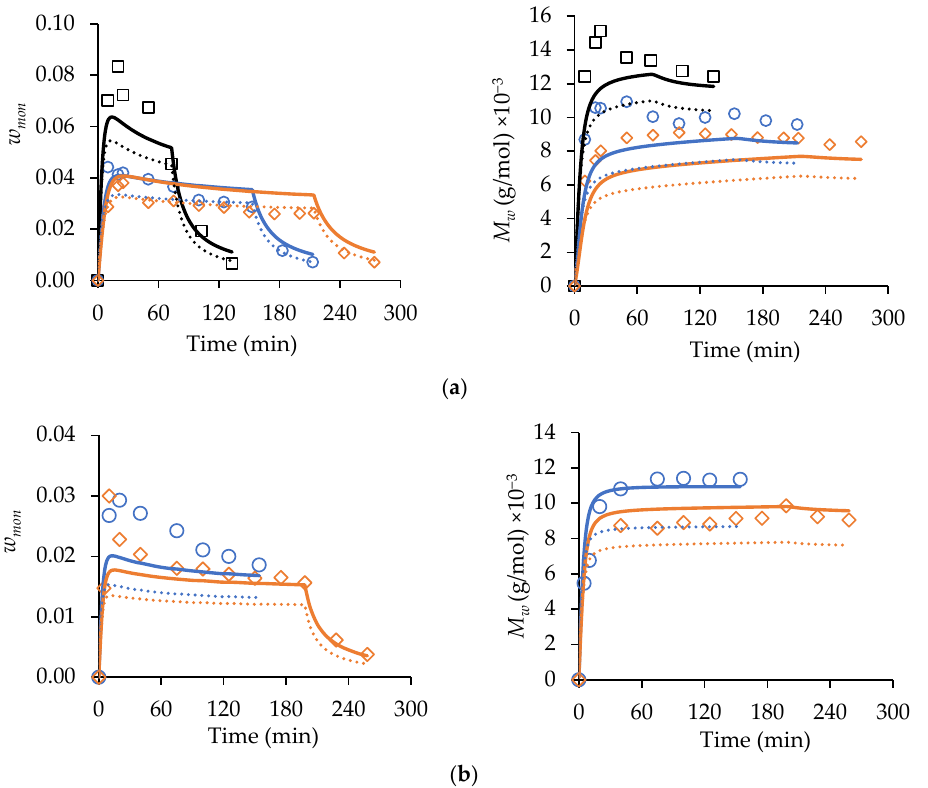
Figure 4. Experimental (symbols) starved-feed semi-batch w mon (left-hand column of plots) and corresponding M w (right-hand column of plots) profiles compared with simulated results with (solid lines) and without (dotted lines) primary radical termination for ( a ) MA homopolymerization with w mon,total = 0.30, 𝛼 𝐸𝑡𝑂𝐻 ⁡ = 0.75, 2.0 wt% AIBN, 70 °C, and ( b ) t-BuAAm homopolymerization with w mon,total = 0.20, 𝛼 𝐸𝑡𝑂𝐻 ⁡ = 0.75, 2.0 wt% AIBN, 70 °C. Feed times are 75 min ( ☐ ), 150 min ( ○ ), and 225 min ( ◇ ). Note that the reported w mon,total and wt% AIBN are expressed relative to the total recipe in the reactor after feeding.